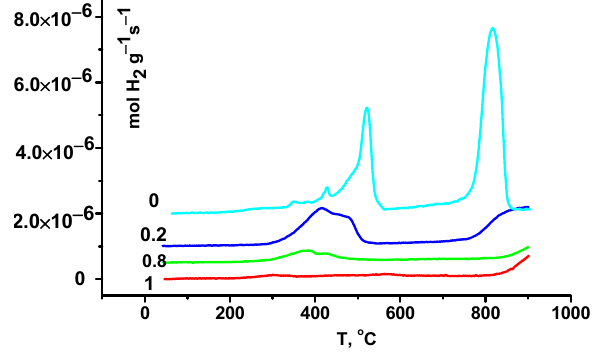
Figure 5. H 2 -TPR curves for LaMn 1 − x Fe x O 3 samples.